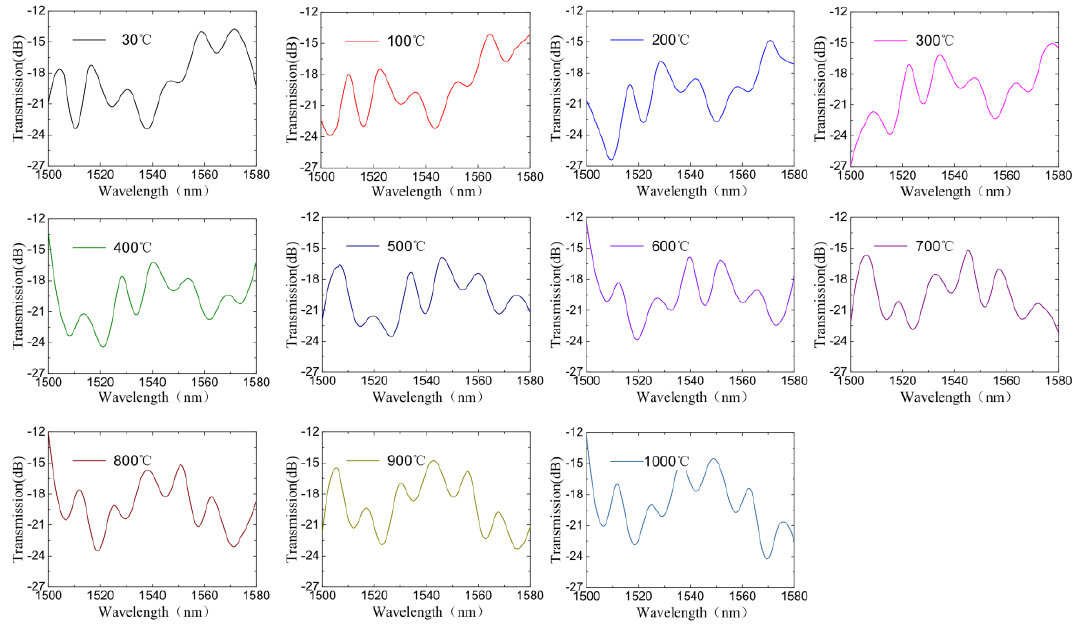
Figure 6. The transmission spectra of the sensing system based on three cascade MZIs at different temperatures.